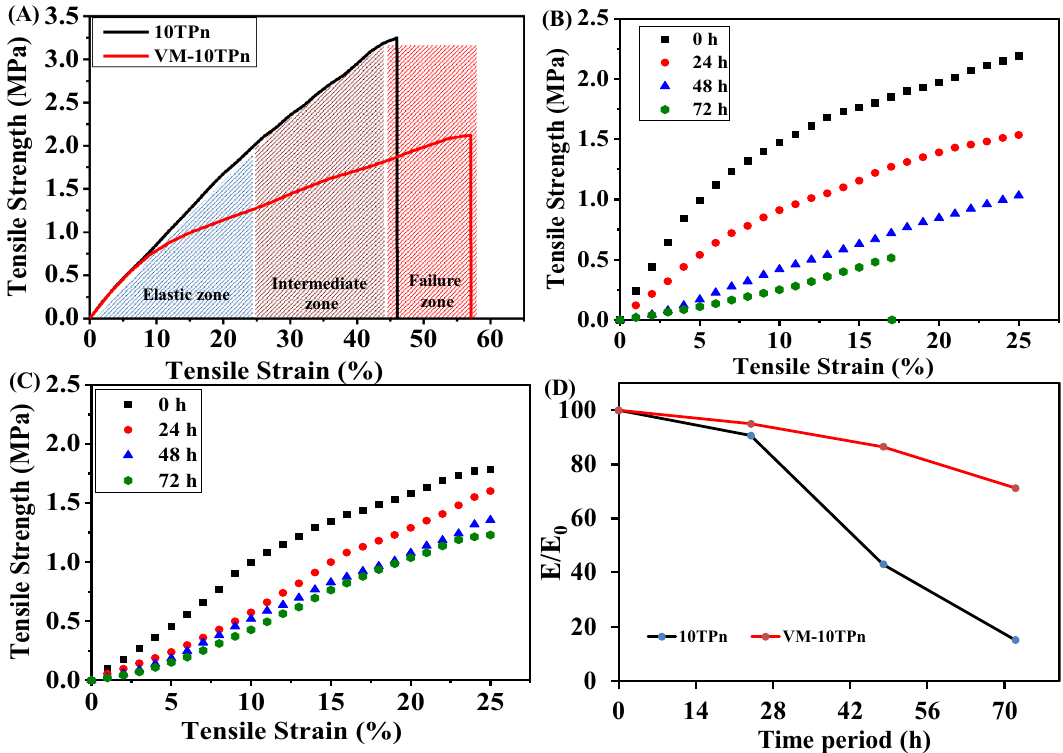
Figure 8. ( A ) Tensile test results, ( B , C ) Tensile stress/strain curves at periodic stretching, and ( D ) Relative variation in tensile modulus of 10TPn and